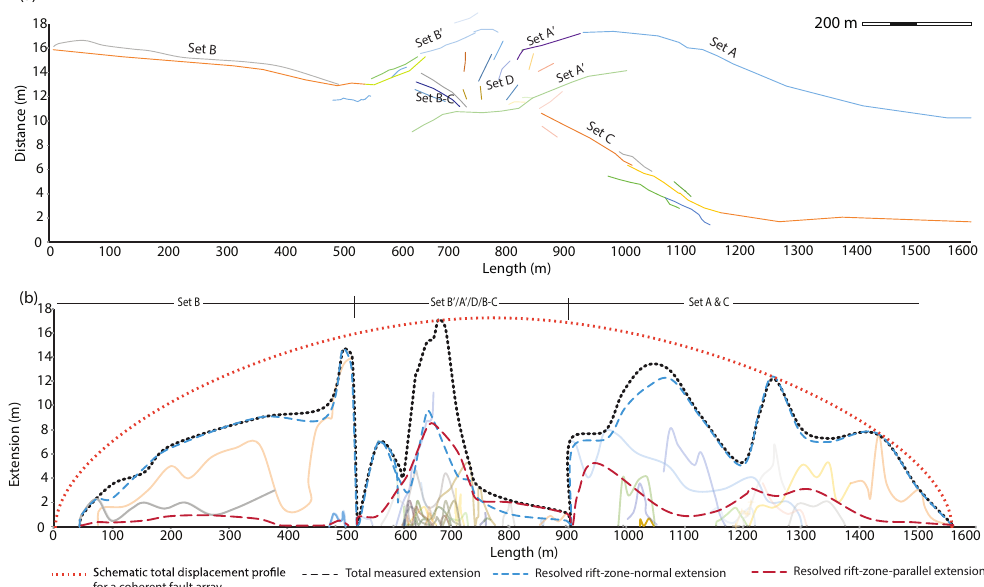
Figure 6. (a) Distribution of mapped faults and fractures in the study area. (b) Profile of horizontal displacement (extension or heave) vs. length for mapped fractures. The dotted black line indicates the total measured extension for structures in each set. Dashed blue lines indicate the calculated component of extension on each fracture set that occurs in a direction orthogonal to the rift zone. Dashed red lines indicate the calculated component of extension on each fracture set that occurs in a direction parallel to the rift zone. Extension across the system as a whole is represented by a hypothetical displacement profile for a fully linked, mature fault array in which the maximum displacement is located centrally along the fault, or array, and tapers to zero at the lateral tips (dotted orange